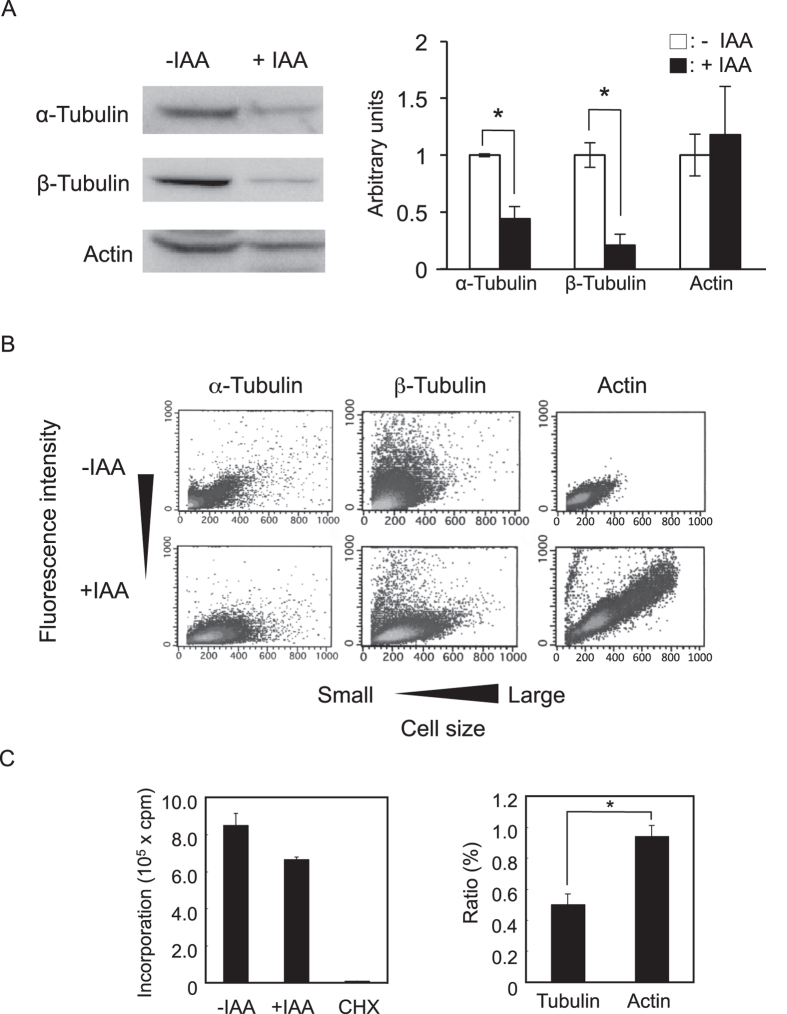
Effects of IAA on intracellular levels and translation of cytoskeleton-related proteins.(A) Cell-free extract was obtained from BY4741 cells treated with (+IAA) or without (-IAA) 0.5% IAA for 4 h. (Left panel) Intracellular levels of α-tubulin, β-tubulin, and actin were estimated using western blot analysis. Each lane contained an equal amount of total proteins based on Bradford protein assay. (Right panel) The levels of α-tubulin, β-tubulin, and actin were also quantified using Fujifilm Multi Gauge Version 2.1. Data are means ± standard deviations of triplicate experiments. *P < 0.05 vs. -IAA. (B) BY4741 cells incubated with (+IAA) or without (-IAA) 0.5% IAA for 24 h were stained with monoclonal anti-α-tubulin DM1A for α-tubulin, mouse monoclonal, anti-β-tubulin TU27B for β-tubulin, and rhodamine-phalloidin for actin. The cellular content of α-tubulin, β-tubulin, and actin was quantified using FACS. Light grey area indicates high cell density. (C) (Left panel) Effect of IAA on translation of total proteins. BY4741 cells were incubated SD medium with (+IAA) or without (-IAA) 0.5% IAA, or with 50 μg/ml cycloheximide (CHX) for 24 h. Incorporation of l-[35S]methionine into acid-insoluble fractions was measured after 1 h. Data are means ± standard deviations of triplicate experiments. P = 0.058. (Right panel) Effect of IAA on translation of α-tubulin and actin. BY4741 cells were incubated in SD medium with or without 0.5% IAA for 24 h. Incorporation of l-[35S]methionine into α-tubulin or actin was evaluated after 1 h. The cell-free extract obtained from the cells was immunoprecipitated with anti-α-tubulin or anti-actin. The ratio of IAA-treated to untreated cells showing l-[35S]methionine incorporation is indicated. Data are means ± standard deviations of triplicate experiments. *P < 0.05 vs. actin.